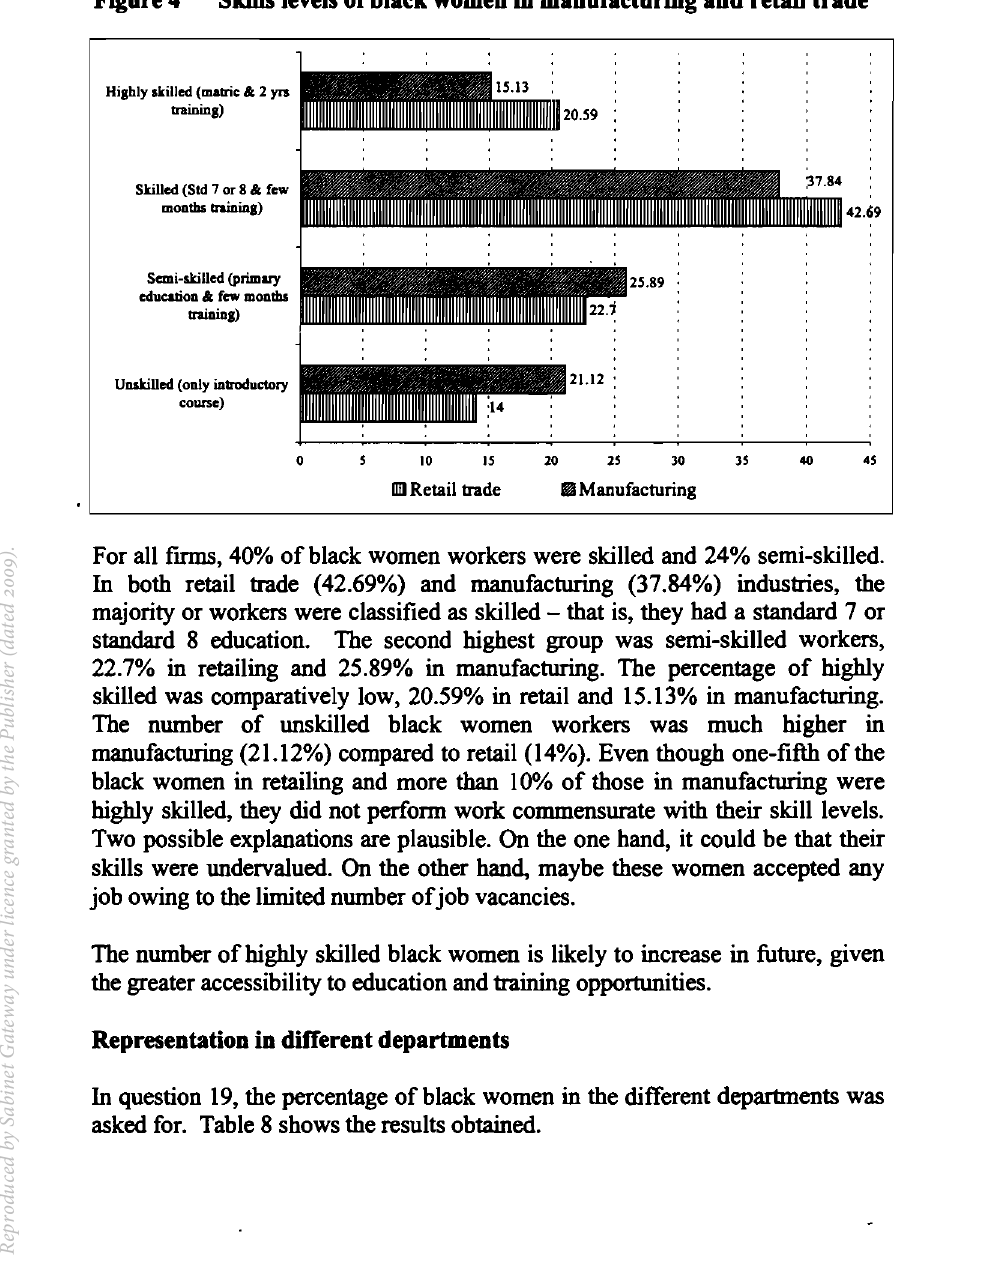
HiShly skilled (mallie" 2 yB aaininS)